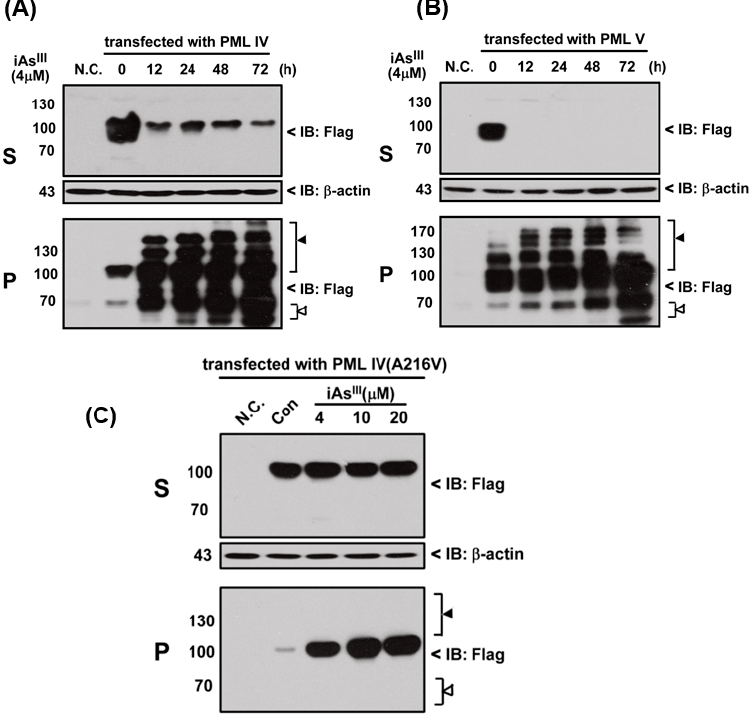
Figure 1. Effects of arsenite (iAs III ) on solubility changes in PML-IV, PML-V and its mutated PML-IV (A216V) in 293T cells. HEK293T cells were transfected with plasmids encoding Flag-tagged PML-IV, PML-V and point mutated PML-IV (A216V) for 24 h. After transfection, PML-transfected cells (i.e., IV and V) were exposed to 4 µM of iAs III at indicated time points (12, 24, 48 and 72 h) to determine the solubility changes of promyelocytic leukemia (PML) proteins in supernatant (S) and detergent-insoluble pellet fractions (P) by Western blot ( A , B ). PML-IV (A216V)-expressed cells (i.e., iAs III —resistant mutant PML) were treated with 4, 10 and 20 µM of iAs III for 6 h, and then determine the PML protein solubility changes ( C ). The white triangle ( △ ) indicates the protein degradation and black triangle ( ▲ ) indicates modification. PML protein and β -actin were detected by using anti-Flag and anti- β -actin primary antibodies (respectively).